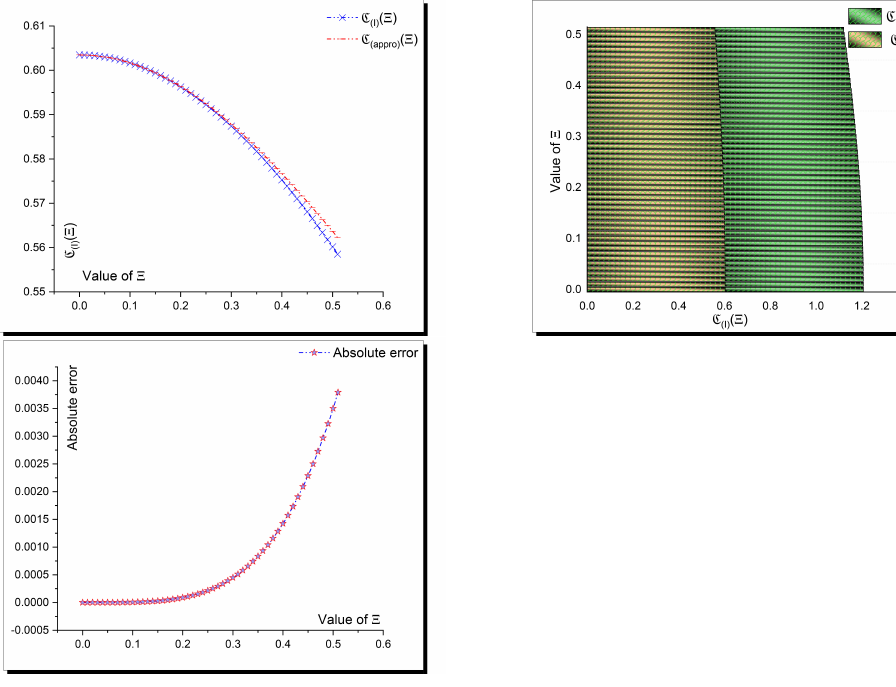
Figure 6. Matching between exact and semi–analytical solutions based on Table 2.